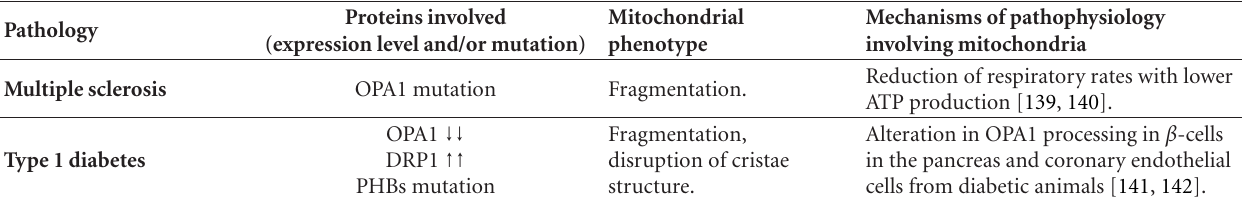
Mechanisms of pathophysiology involving mitochondria Reduction of respiratory rates with lower ATP production [139, 140]. Alteration in OPA1 processing in β -cells in the pancreas and coronary endothelial cells from diabetic animals [141,